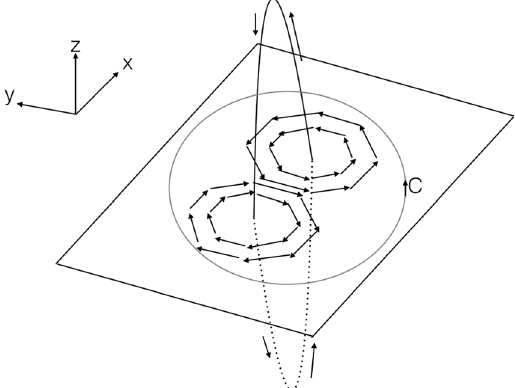
Figure 1. A single vortex loop in 3d space, piercing the 2d x - y plane giving rise to a pair of vortices with opposite circulations and Berry phase evaluated along contour C